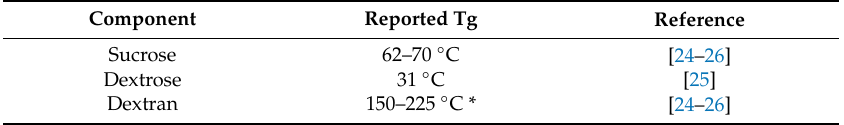
Table 1. Glass transition (Tg) temperature for the di ff erent components present in the